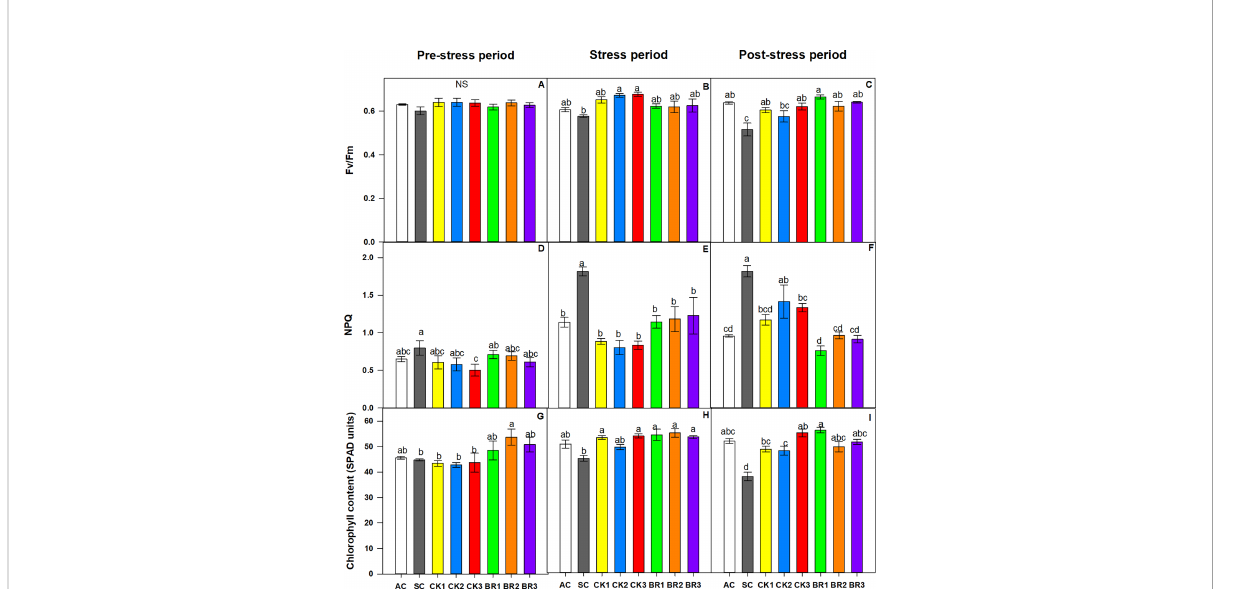
FIGURE 5 Effect of the number of applications of two growth regulators (cytokinins (CK) or brassinosteroids (BR)) on the ratio of variable to maximum chlorophyll fl uorescence of photosystem II (F v /F m ) before the stress period (A) , during the stress period (B) , and after the stress period (recovery) (C) , non-photochemical quenching (NPQ) before the stress period (D) , during the stress period (E) , after the stress period (F) , and chlorophyll content before the stress period (G) , during the stress period (H) , and after the stress period (I) in rice plants of genotype F2000 subjected to combined heat stress (40°C day/30°C night) at 88 days after emergence (DAE). The treatments evaluated were as follows: absolute control (AC), heat stress control (SC), one foliar spray of CK (CK1), two foliar sprays of CK (CK2), three foliar sprays of CK (CK3), one foliar spray of BR (BR1), two foliar sprays of BR (BR2), and three foliar sprays of BR (BR3). Each column represents the mean of fi ve data ± standard error (n = 5). Bars followed by different letters indicate statistically signi fi cant differences according to Tukey ’ s test (P ≤ 0.05). Equal letters indicate that the means are not statistically signi fi cant ( ≤